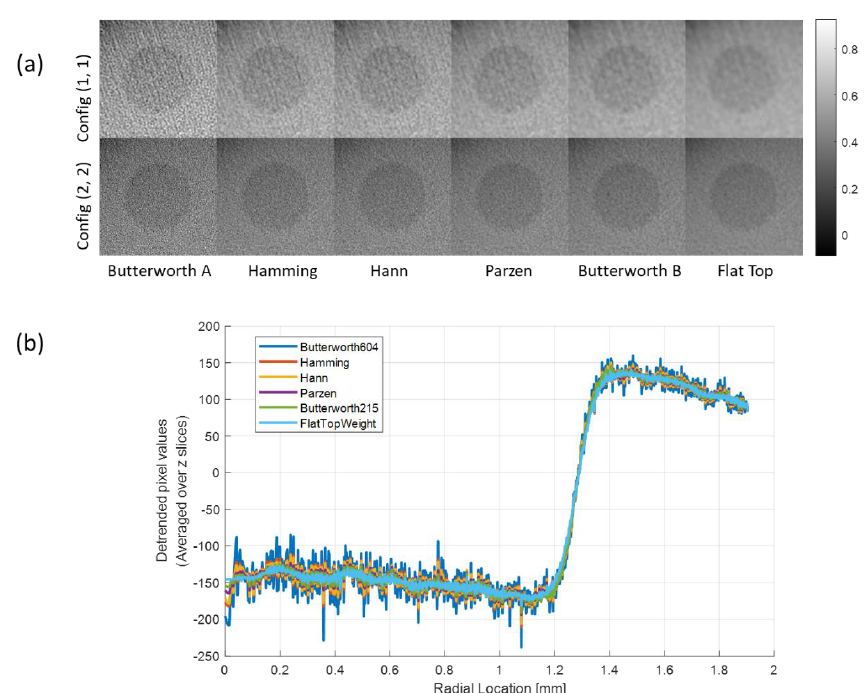
Figure 8. ( a ) Reconstructed image of M1 with different configurations according to the different windows and ( b ) the radial profile of configuration (2, 2).